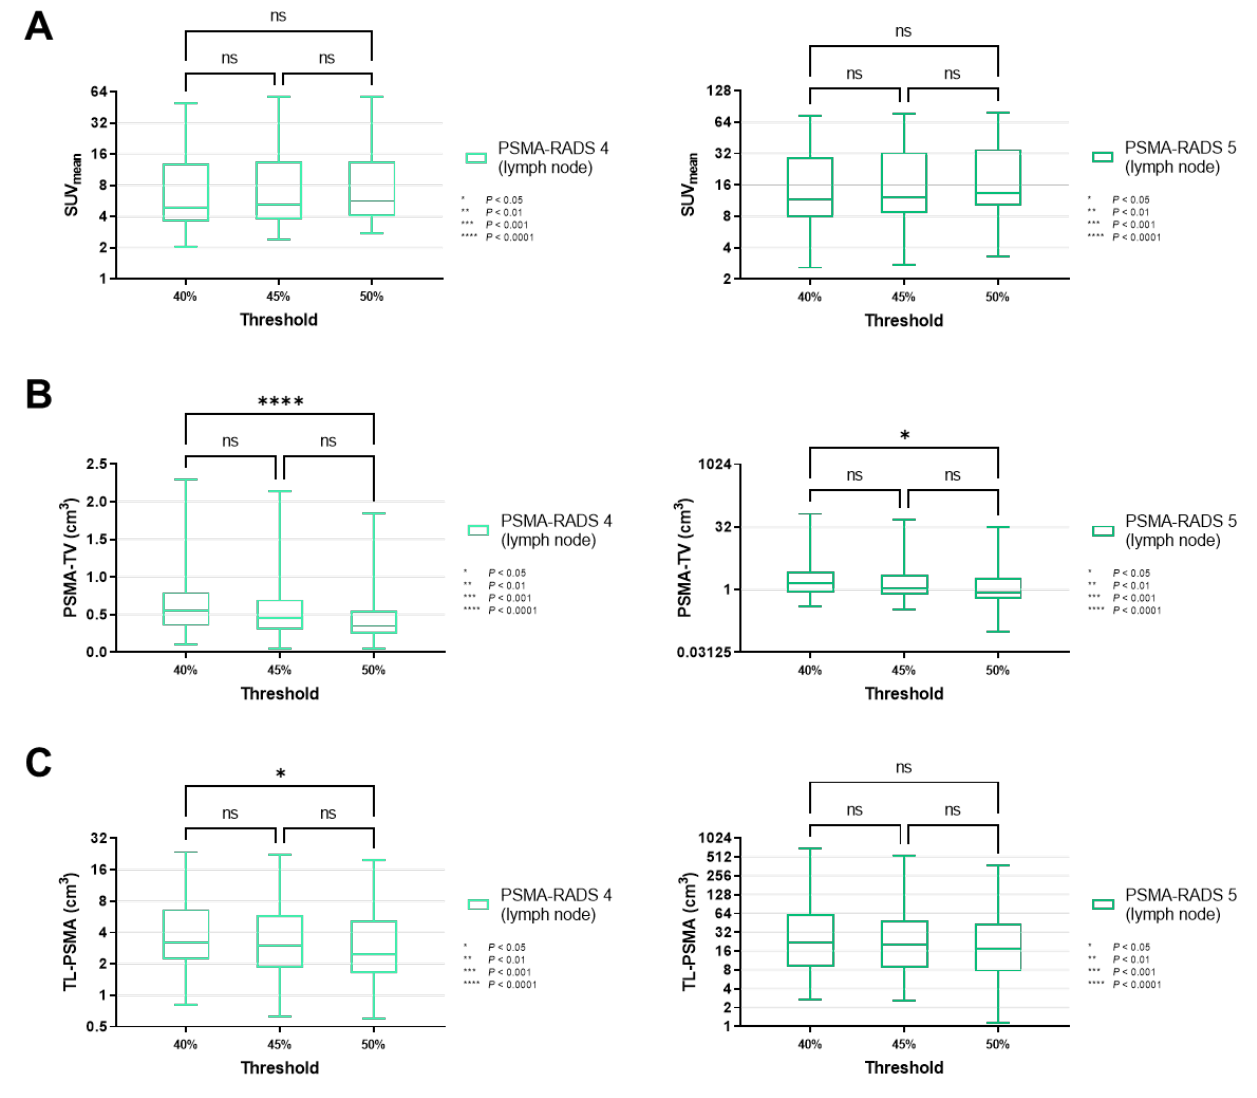
Figure 4. Box-and-whisker charts showing the mean standardized uptake values (SUV mean , ( A )) and volumetric parameters [PSMA-avid tumor volume (PSMA-TV, ( B )), and total lesion (TL-PSMA, ( C ))], depending on the chosen intensity threshold (40 vs. 45 vs. 50%), for lymph node lesions classified as PSMA-RADS-4 or -5. ( A ) Similar to SUV mean on an overall lesion level (Figure 3A), values of lymph nodes categorized as PSMA-RADS-4 ( p ≥ 0.40) and -5 ( p ≥ 0.87) did not differ significantly between different intensity thresholds. ( B , C ) PSMA-TV reached significance in a comparison of intensity thresholds of 40 vs. 50% ( p = 0.0239), in a manner similar to an overall lesion level (Figure 3B), thereby suggesting that these findings are primarily driven by lymph node lesions. The same applies to TL-PSMA (Figure 3C), which only showed a significant difference when comparing 40 and 50% in PSMA-RADS-4 lymph node lesions ( p = 0.0453), but not for the skeleton ( p ≥ 0.33, Figure 5). Data are shown on a logarithmic scale (exception: linear scale for PSMA-TV in the PSMA-RADS-4 cohort). PSMA-RADS = prostate-specific membrane antigen reporting and data system.